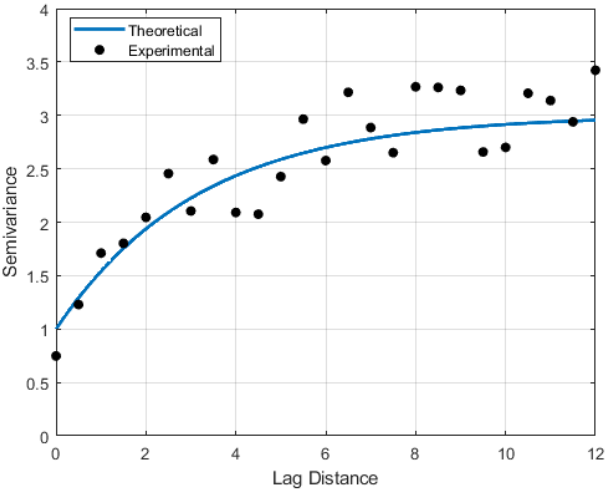
Figure 2. Sample of the semivariogram as function of the lag distance. Scattered points represent the experimental semivariogram. The fitted line is the theoretical semivariogram.